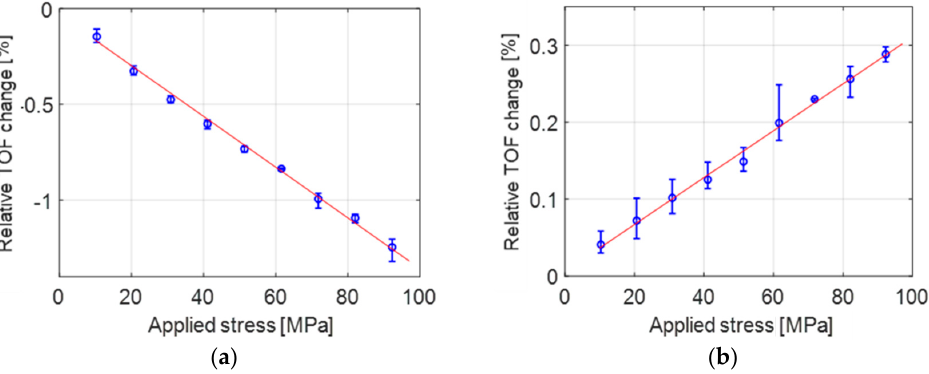
Figure 11. Change rates of the TOF with respect to the applied stress in specimen SA.1 for measurements of ( a ) K 1 and ( b ) K 2 .